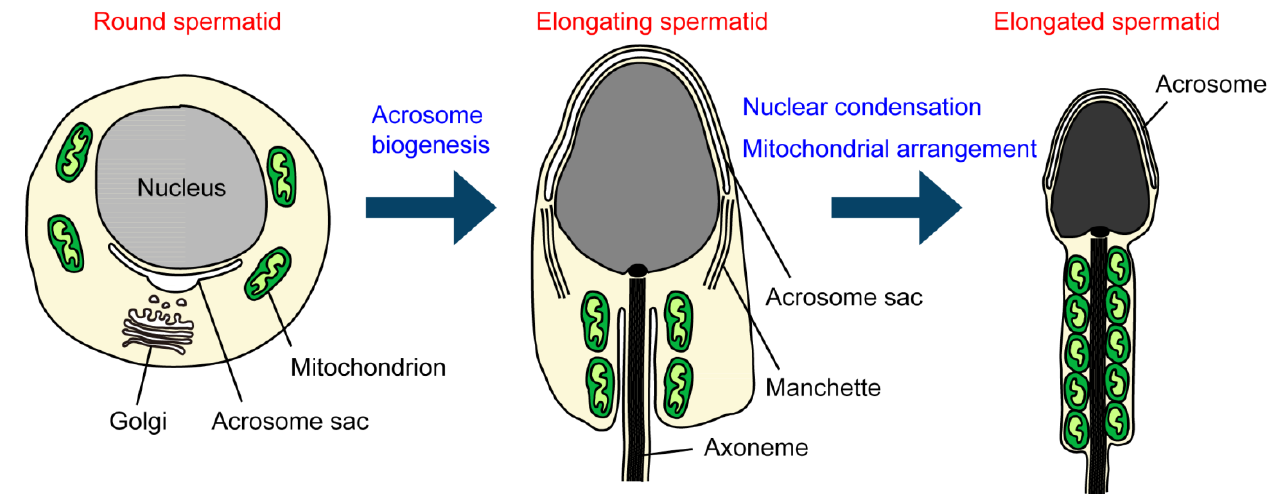
Figure 1. Biogenesis and morphological changes in intracellular membranous organelles during spermiogenesis. In round spermatids, the acrosome sac is formed and enlarged by the continuous fusion of Golgi-derived vesicles. In elongating spermatids, the acrosome sac then flattens and covers the anterior half of the nucleus. In the nucleus, histone-to-protamine replacement occurs, which allows the nucleus to become condensed with the aid of the manchette structure. In elongated spermatids, mitochondria are aligned along the anterior part of the flagellum (the midpiece) and tightly packed to form the helically arranged mitochondrial